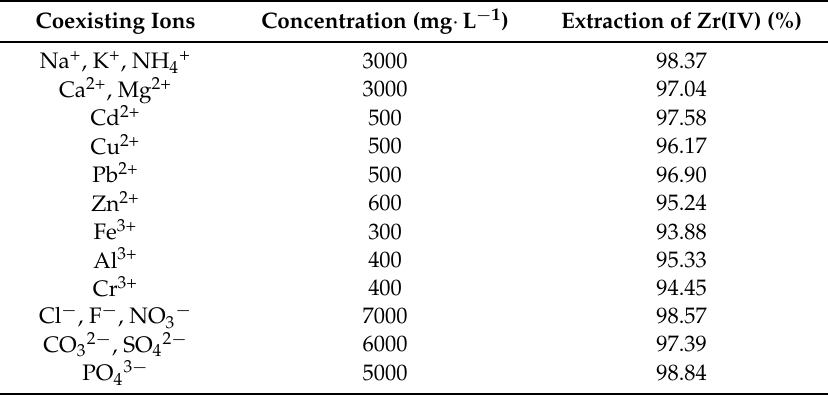
Interferences effect on the extraction of 1.0 mg ¨ L ´ 1 Zr(IV) on 20.0 mg SG-APTMS-N,N-EPANTf 2 ( N =